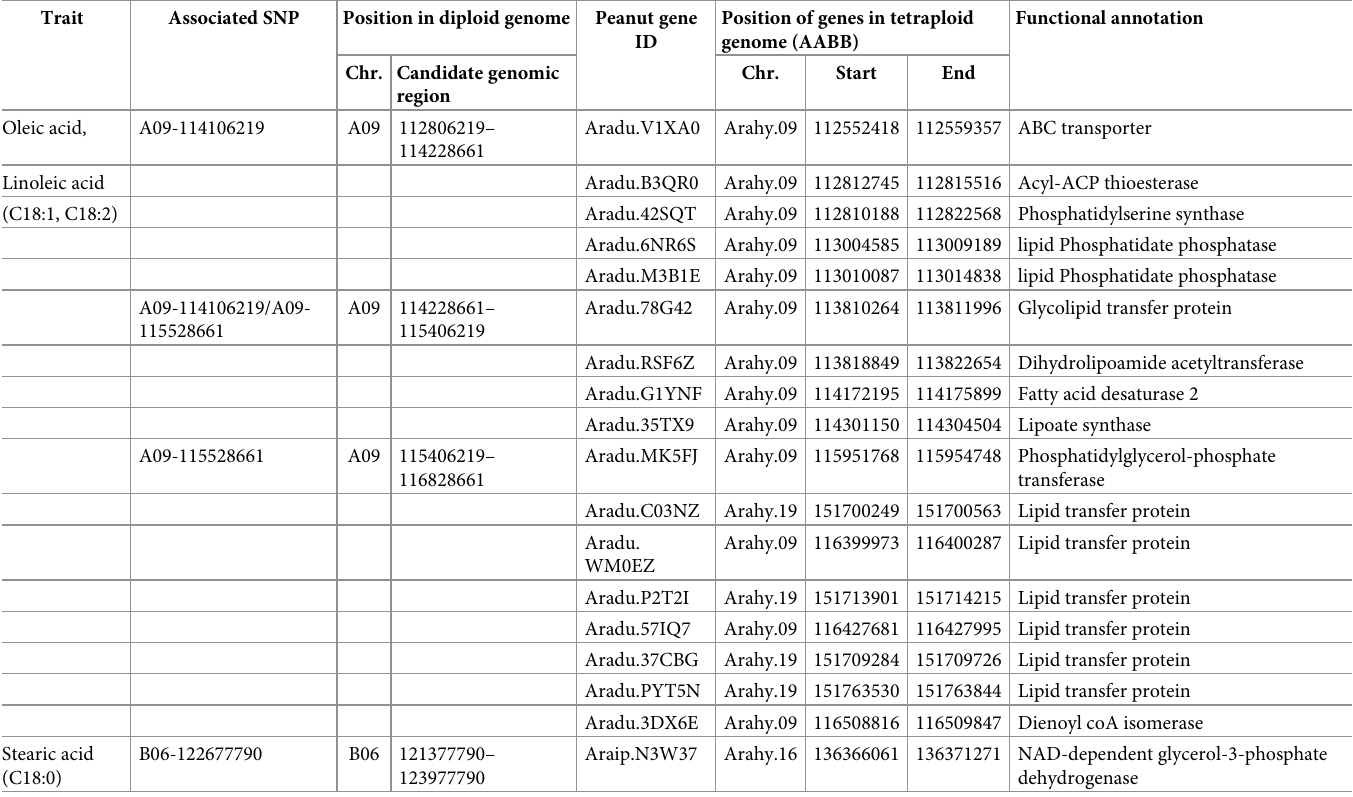
Table 4. Candidate genes underlying stable major associated loci on chromosome A09 and